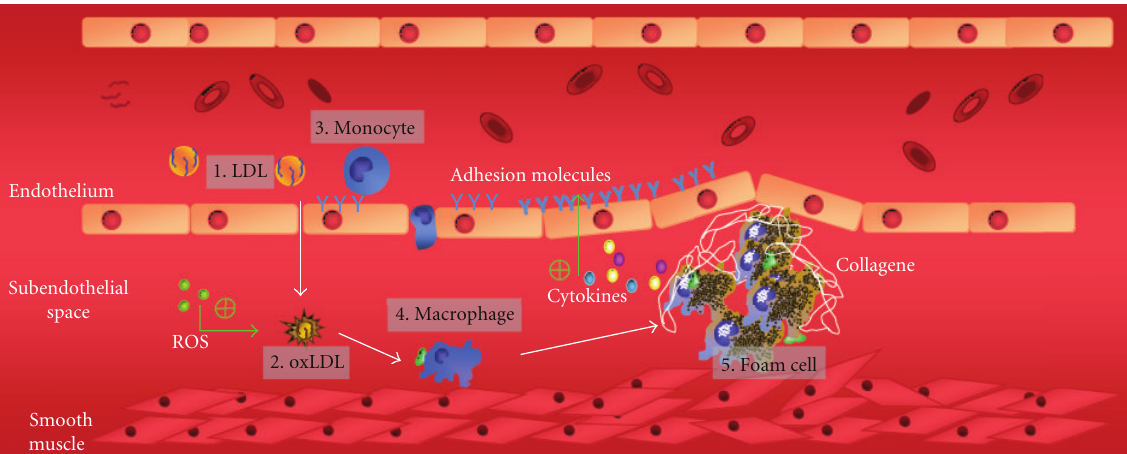
Figure 8: Early stages of the atherogenic process. (1) Low-density lipoproteins (LDLs) reach the subendothelial space. (2) LDLs become oxidized by reactive oxygen species (ROS). (3) Oxidized LDLs act as chemotactic molecules for monocytes. (4) Monocytes di ff erentiate in macrophages within the subendothelial space (5) Macrophages further phagocyte oxidized LDL with the consequent lipid accumulation in their cytoplasm, originating a foam cell that favours an inflammatory response by stimulating the endothelial expression of adhesion